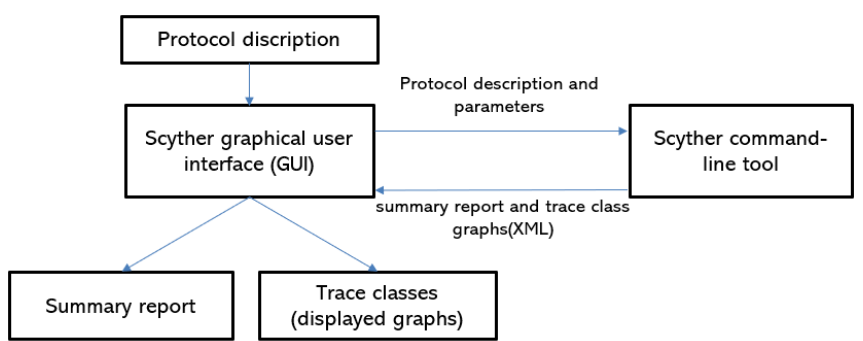
Figure 4. Basic framework of the scyther